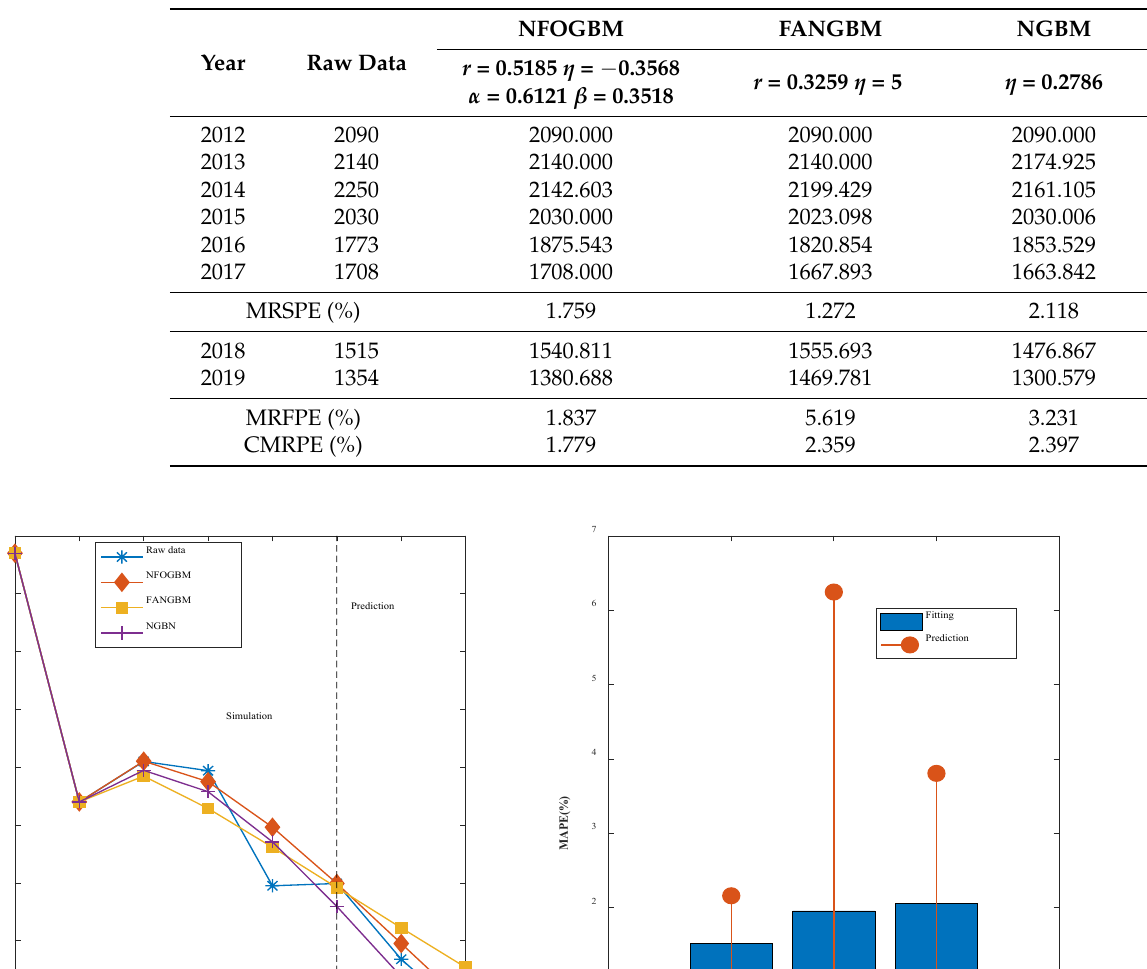
Table 5. Modeling results for SPFM.